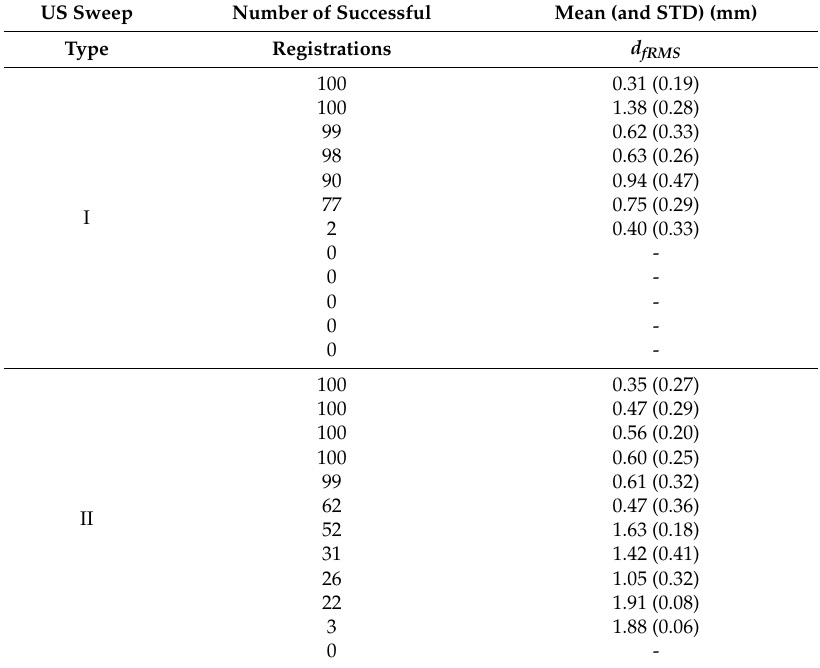
Table 2. Number of successful registrations and the mean RMS TRE (i.e., mean df RMS ) values for each US sweep averaged over all successful registrations in Test II. For each registration, df RMS describes how far a volume is away after registration from its assumed